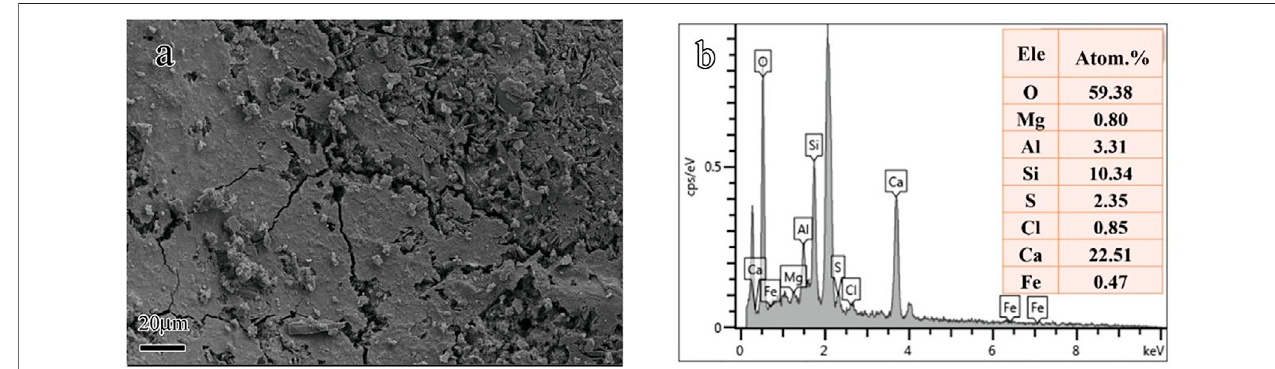
FIGURE13|(A) SEMmorphologyand (B) correspondingEDSresultsofthecementpasteinconcretemodi fi edwithnanoAl 2 O 3 afterF/TandW/Dcyclesin3 wt.% of CaCl 2